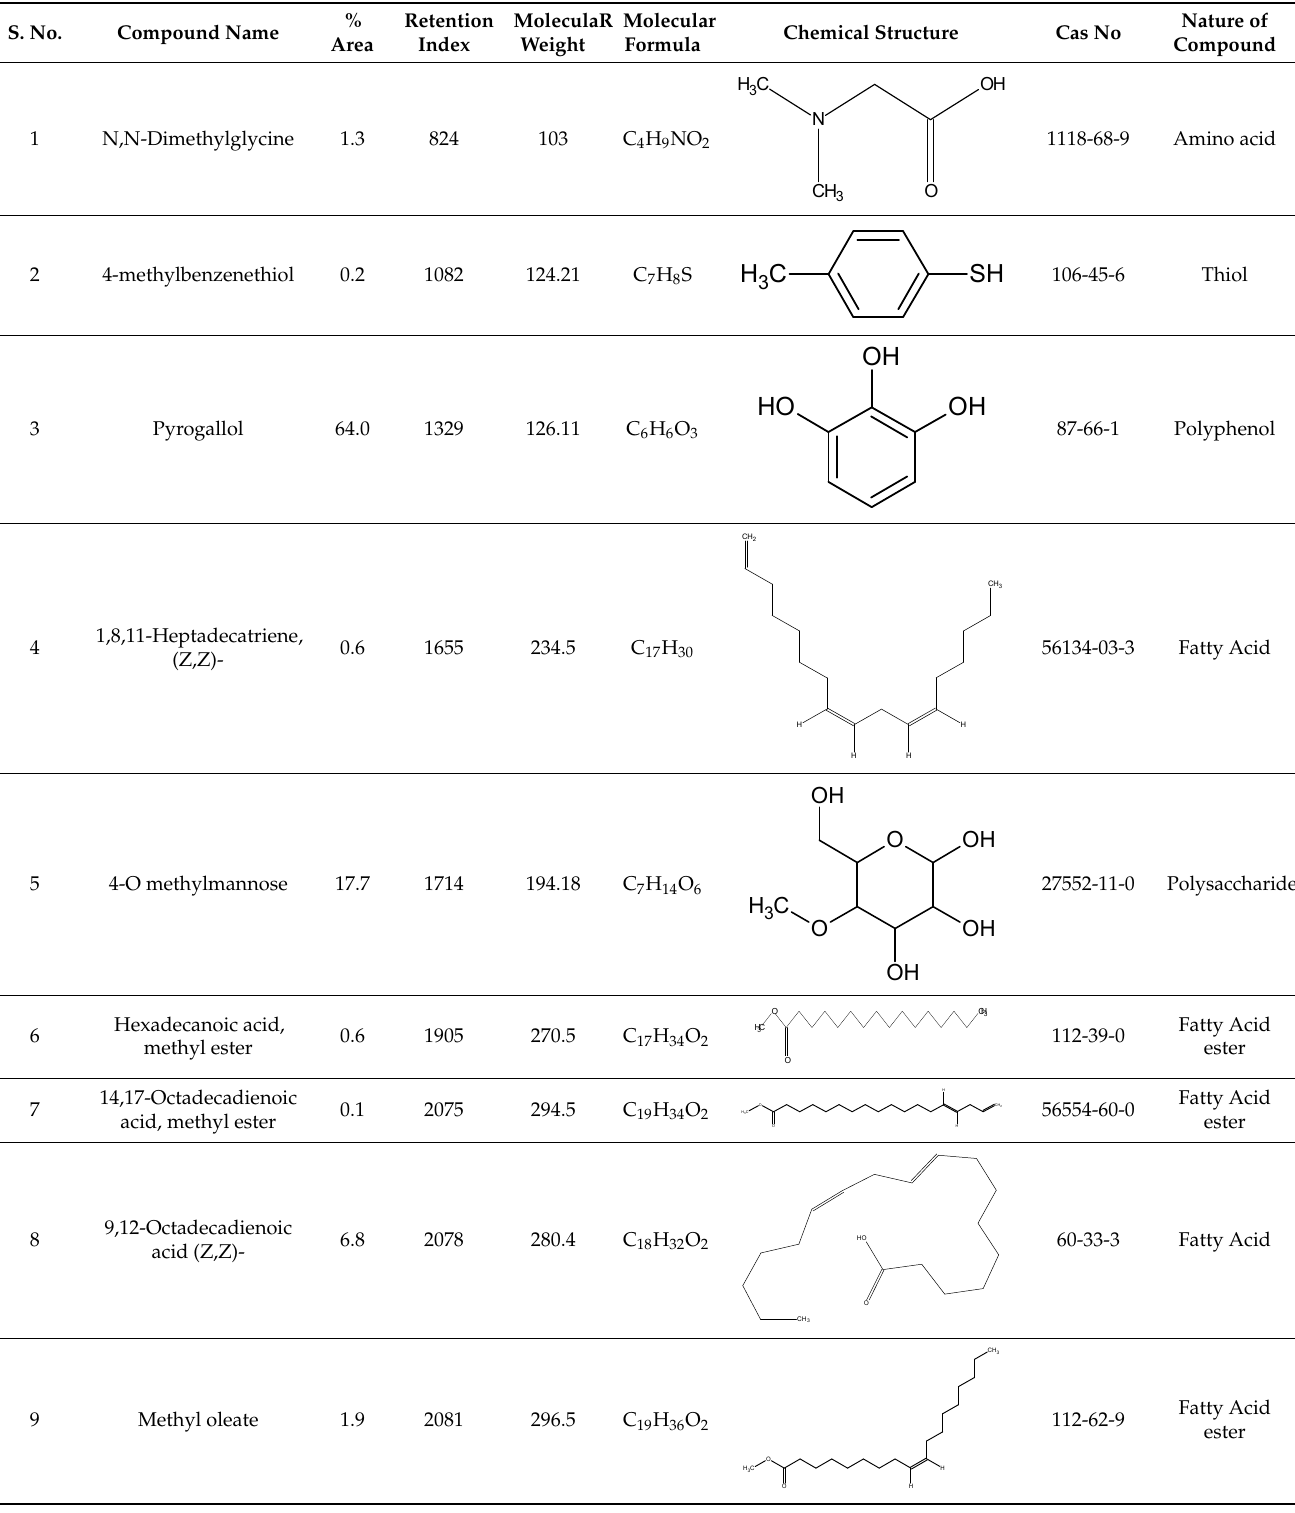
Table 1. List of Phytoconstituents present in A. nilotica methanolic extract. S.